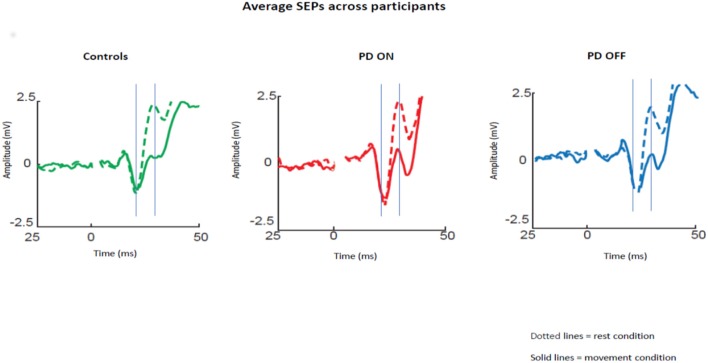
Average SEPs across participants recorded from the left somatosensory cortex for PD patients OFF medication, ON medication, and control subjects. Solid lines show data for median nerve stimulation given at movement onset and dotted lines during baseline. The gray lines show the mean time of the peaks of the N20 and P25 components.